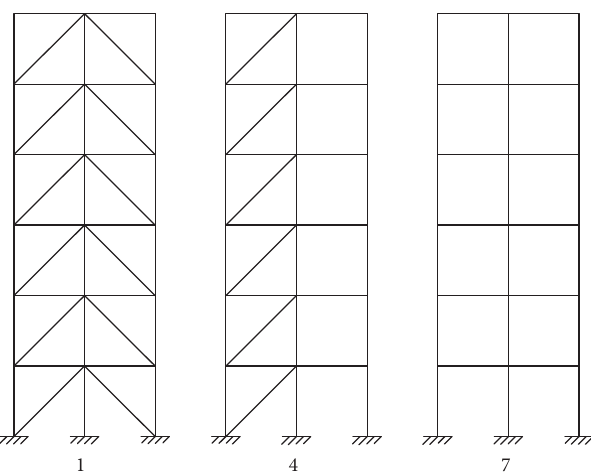
Figure 7: Changes in the basic frame scheme under growing horizontal dynamic loading (following